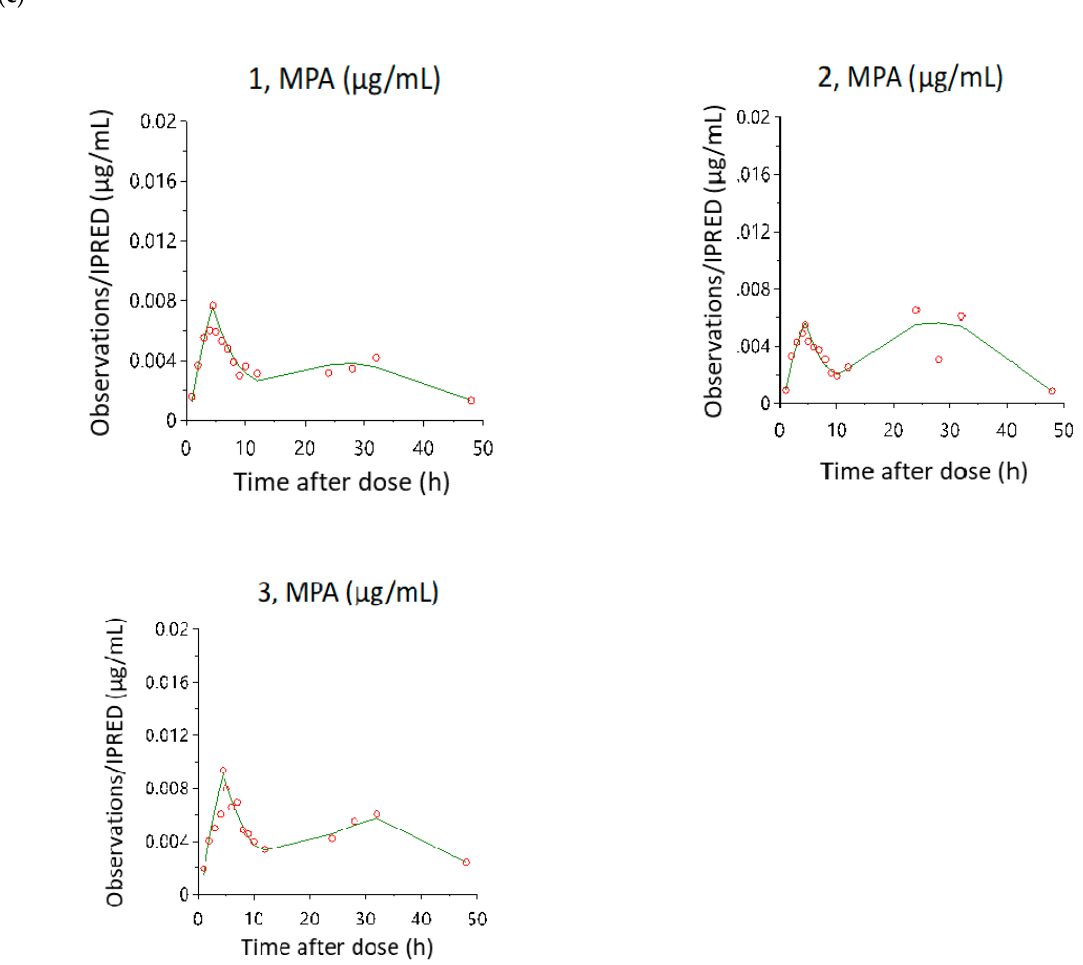
Figure 5. Goodness-of-fit plots of each rat showing individual predictions (IPRED, green line) or observations (red dots) versus time after dose route: ( a ) IV; ( b ) oral; ( c ) supralingual.